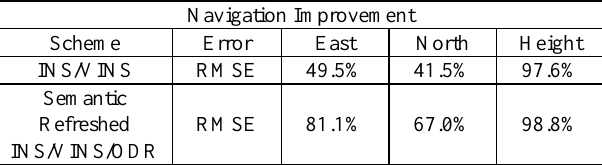
Table 2. Summary of navigation improvement of the indoor